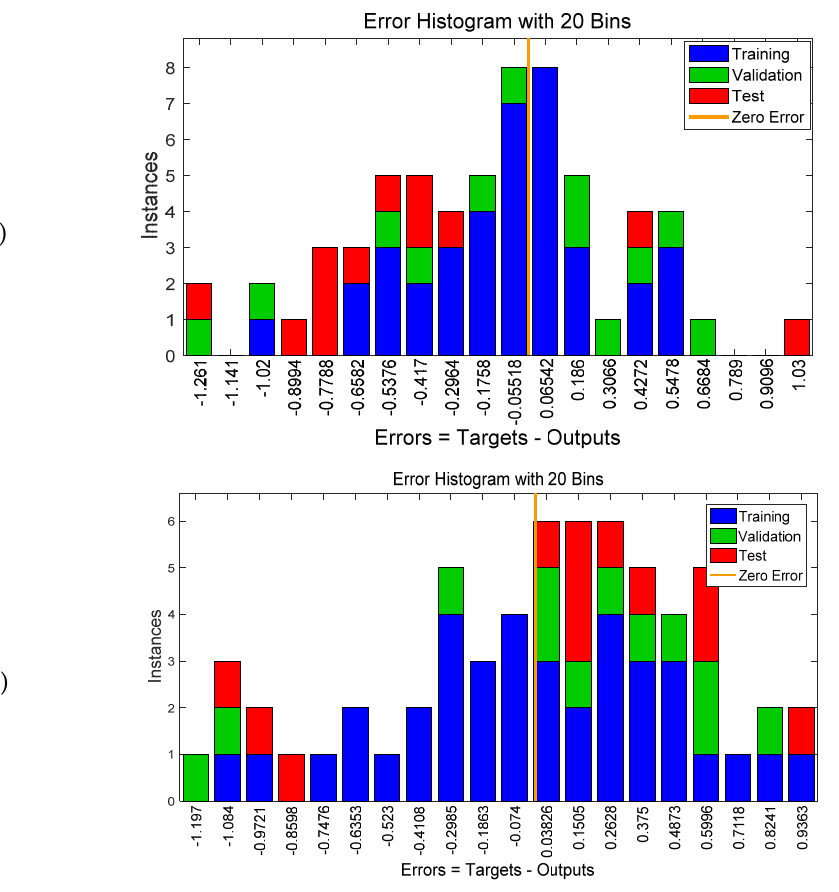
Figure 6. Error histogram chart having 20 bins for the NARX ( a ) and the FTD ( b ) neural network.